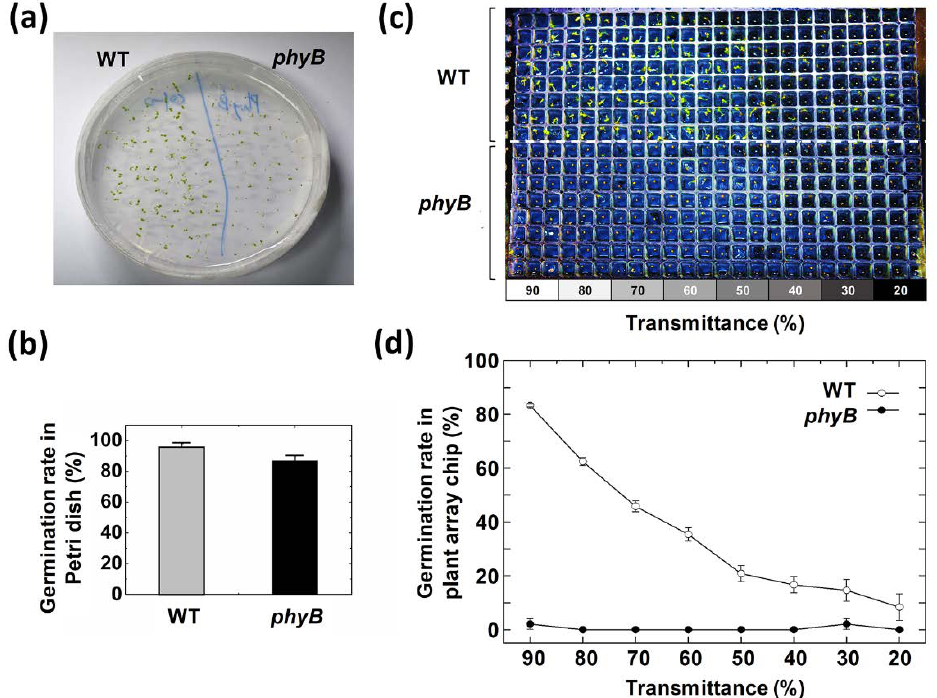
Figure 5. Effect of the red light intensity on the germination rate of wild type (WT) and phytochrome B mutant ( phyB ) seeds. ( a , b ) Germination test results after 72 h of incubation under a red light condition of 2 μmol · m –2 · s –1 in a Petri dish. ( c , d ) Germination comparison of WT and phyB seeds in a plant array chip. ( c ) Top view of a single plant array chip showing different germination behaviors. ( d ) Graph